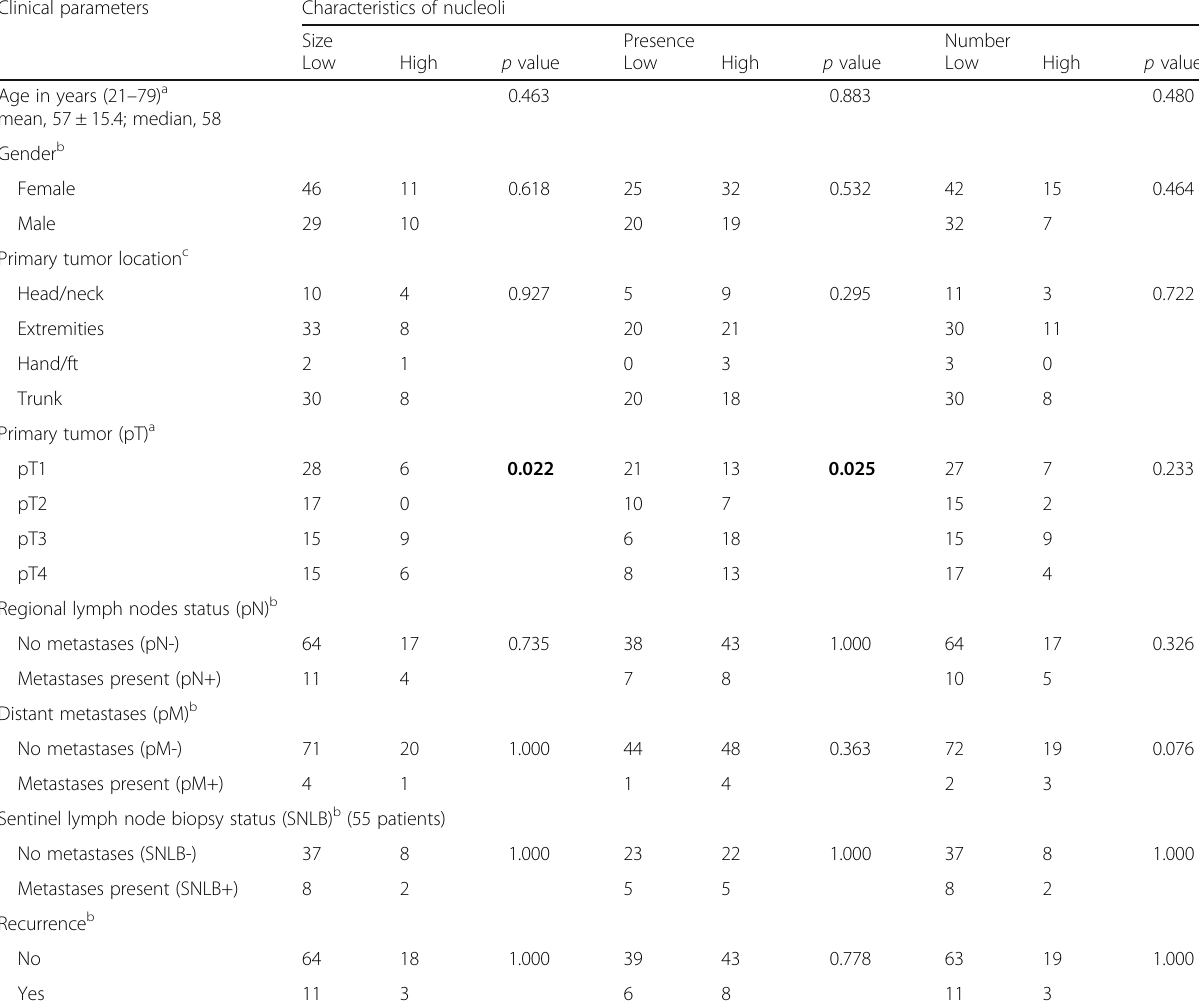
Table 1 Correlations between characteristics of nucleoli in malignant melanocytes and clinical parameters Clinical